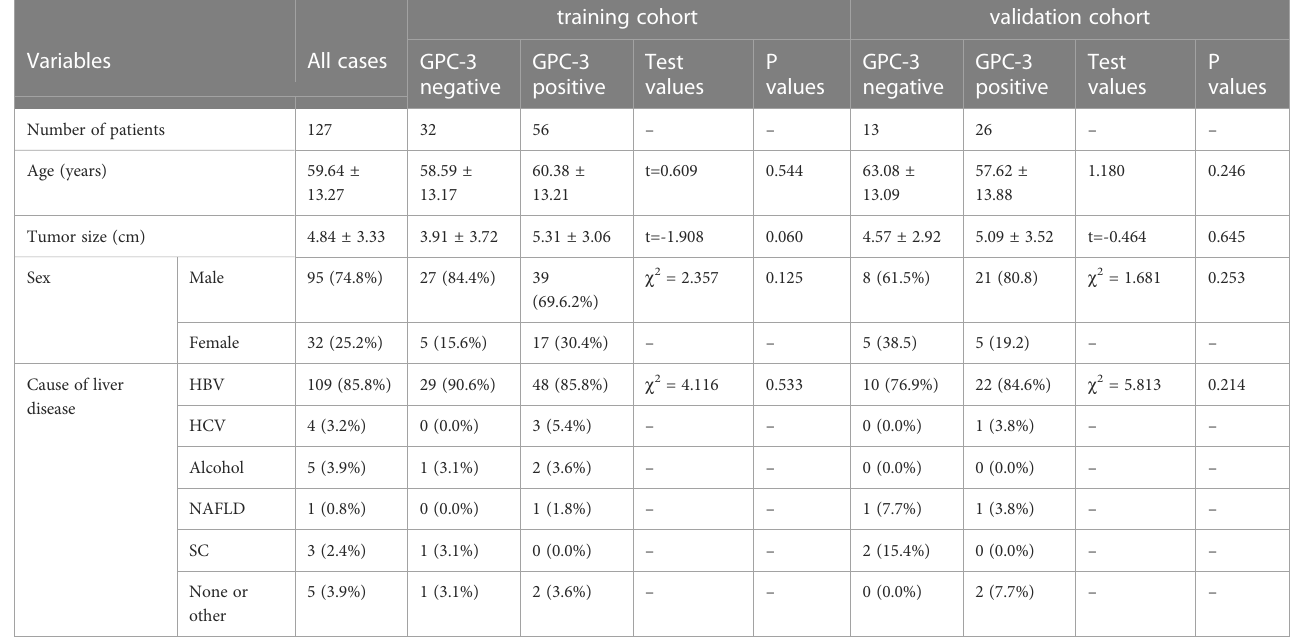
TABLE 1 Clinical and pathological characteristics of study patients.